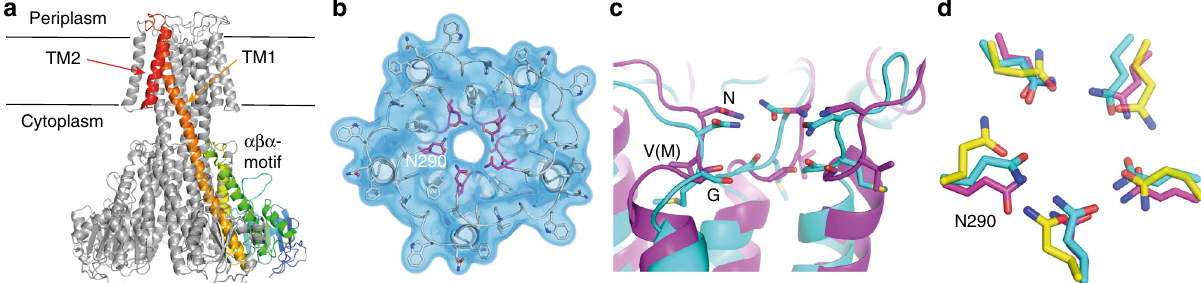
Fig. 1 The structure of the full-length ZntB. a Side view, four subunits of ZntB pentamer are coloured grey, and one is coloured rainbow from blue (N-terminus) to red (C-terminus); the position of the membrane is indicated, trans membrane helices 1 and 2 as well as αβα -motif are labelled. b Top view (from periplasm) onto ZntB — 10 trans membrane helices are arranged cylindrically, with TM2 ring at the periphery. Experimental density is contoured in blue. The connecting loops provide residues for the selectivity fi lter (in magenta), further exempli fi ed in ( c ) structural comparison of selectivity fi lters from EcZntB (magenta) and TmCorA (cyan), only three out fi ve monomers are shown ( d ). The overlay of Asn rings (of GxN motif) from ZntB (magenta), TmCorA (cyan) and MjCorA (yellow). Note that ZntB forms a slightly wider entry point to the